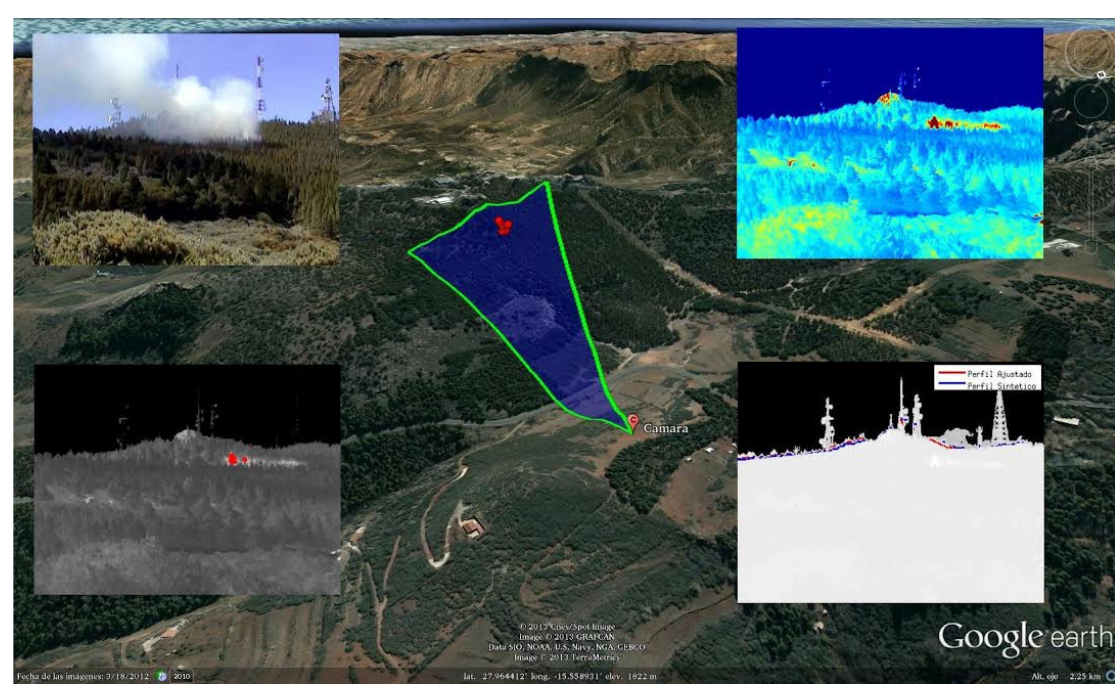
Figure 14. Final result of the RDMU in full autonomous